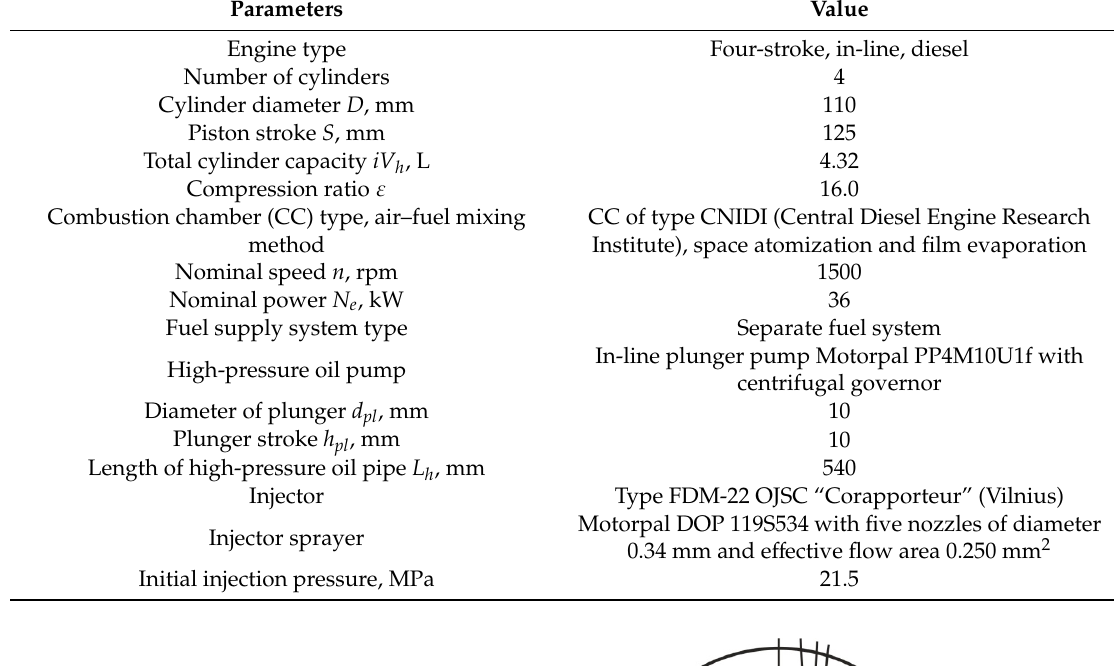
Table 1. Structure and operational parameters of D-243 diesel engine.